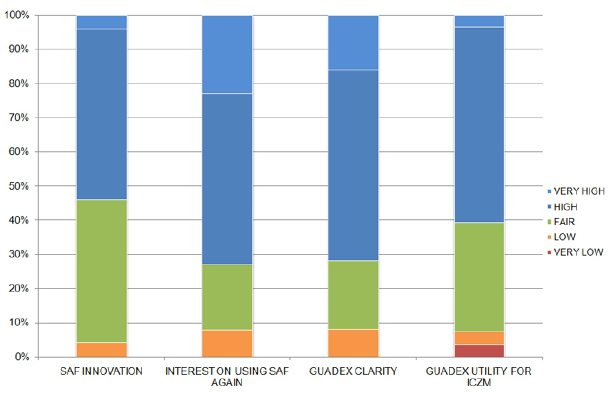
Fig. 9 . Stakeholders’ evaluation of SAF and GUADEX after bilateral discussions with